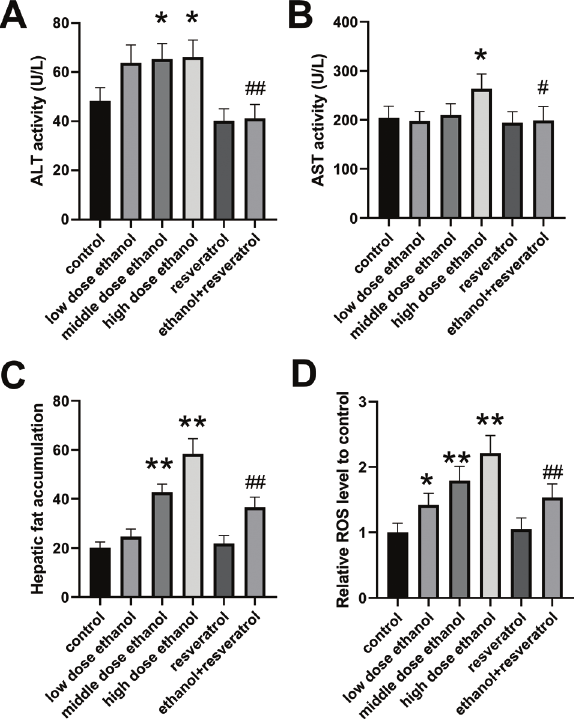
Fig. 1. Effects of dietary Resveratrol supplementation on he- patic enzymes release and ROS levels in rats. (A) Serum ALT, (B) AST level, (C) hepatic fat accumulation, and (D) relative ROS levels in the experimental groups. # P < 0.05, ## P < 0.01 vs high dose ethanol group; *P < 0.05, **P < 0.01 vs control